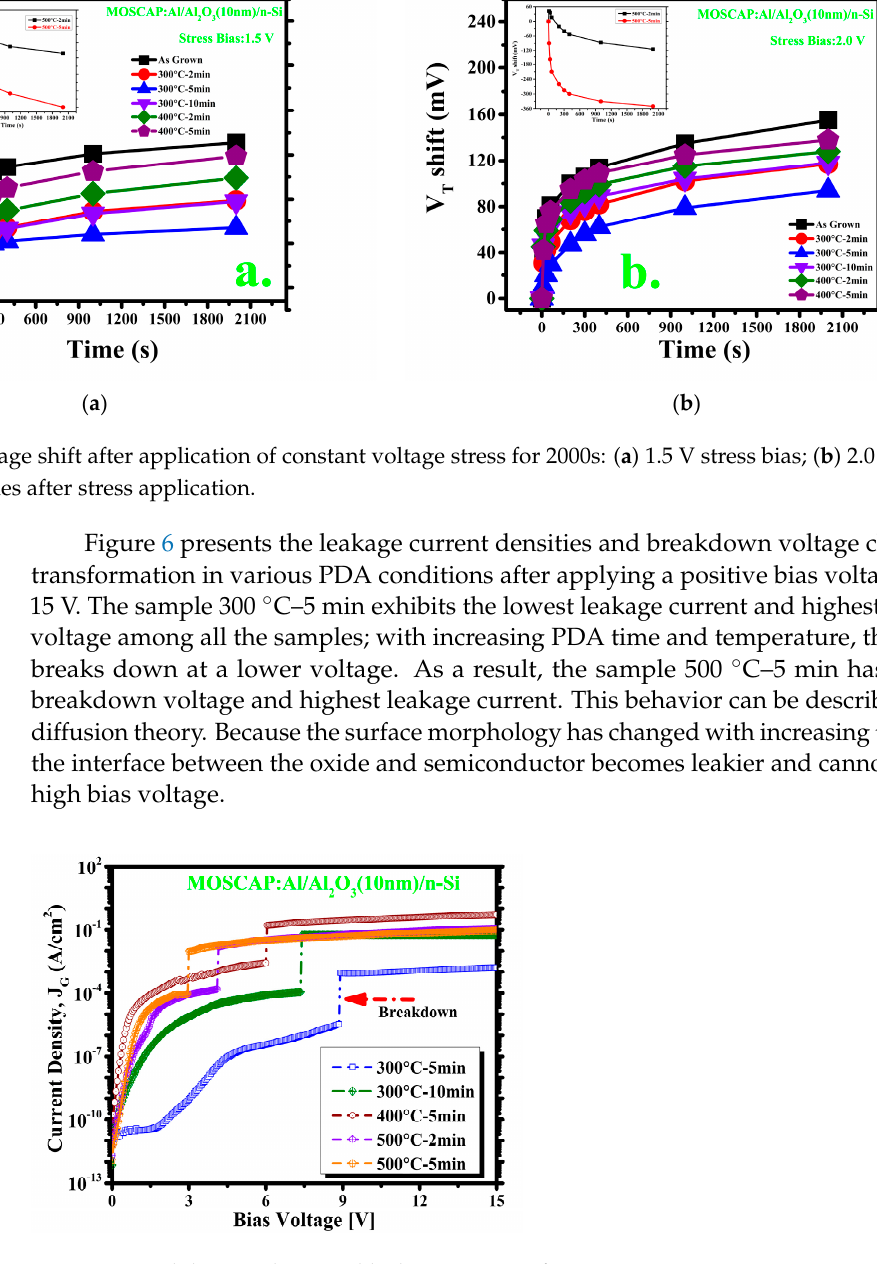
Figure 6. Breakdown voltage and leakage current of